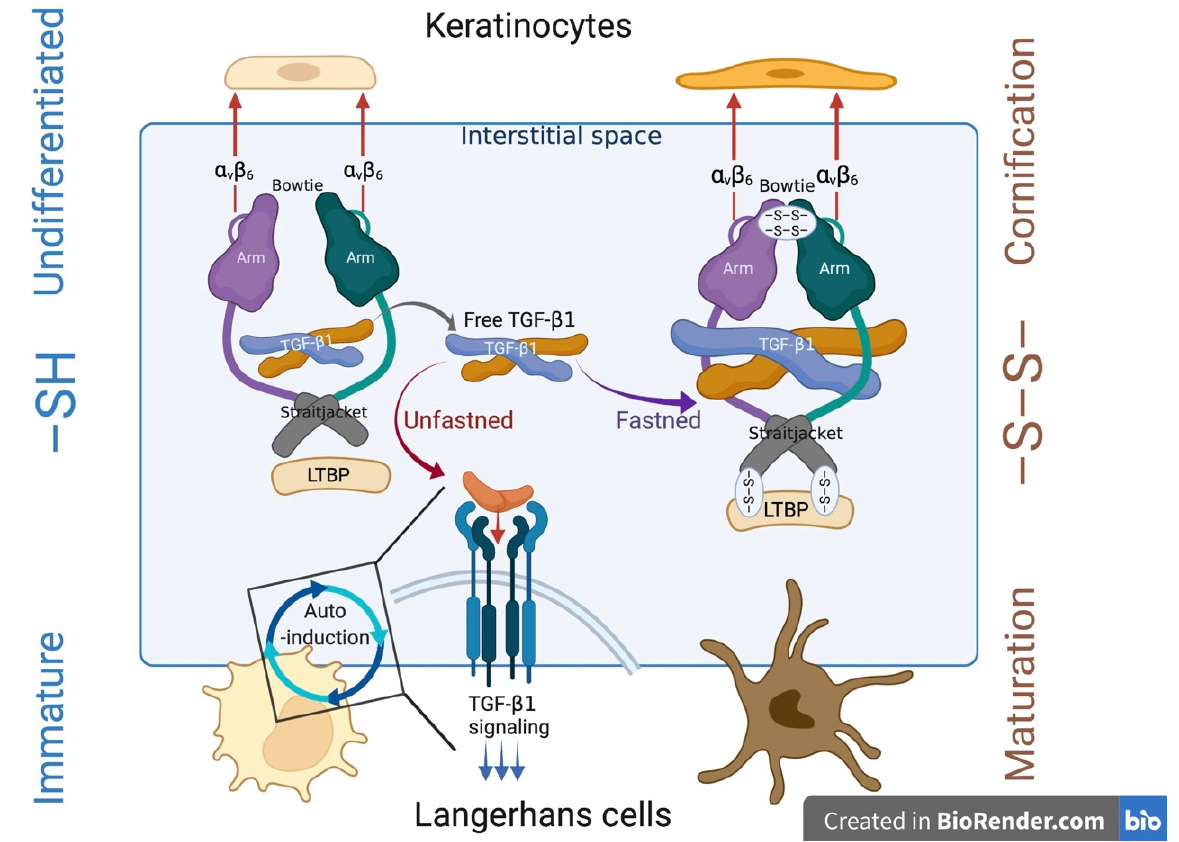
Figure 2. We hypothesized a “Structural imprinting” of the cutaneous immune effector functions. Keratinocytes and Langerhans cells (LCs) might crosstalk via reduction and oxidation [thiol (–SH) and disulfide (–S–S–)] status in the epidermis. Keratinocyte tether LCs via α v β 6 integrin. Epidermal retention of LCs requires the cell-autonomous transform growth factor-beta 1 (TGF- β 1) signaling. The prodomain (proTGF- β “fastens” free TGF- β via disulfide cross-linkages in the bowtie and straitjacket regions. The arm domain anchors keratinocytes via α v β 6 integrin and negatively regulates the biological activity of TGF- β in the extracellular matrix. Successful cornification involves disulfide cross-linkages of the junctional component, thus possibly permanently inactivating TGF- β and promoting LC